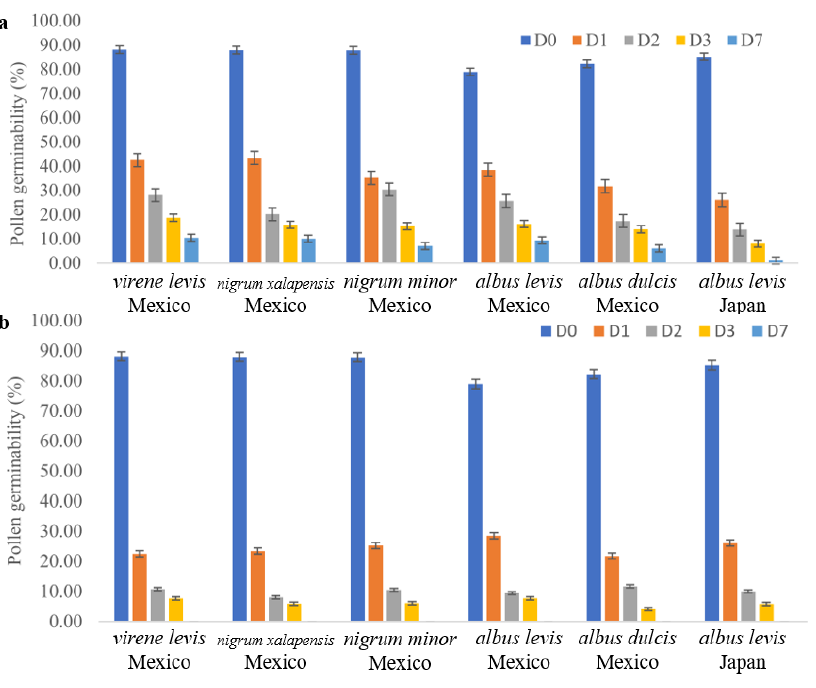
Figure 2. Pollen viability of 5 Mexican and 1 Japanese S. edule after 7 days. Error bars indicate ± S.E. ( a ) under 4 °C. ( b ) under 25 °C.